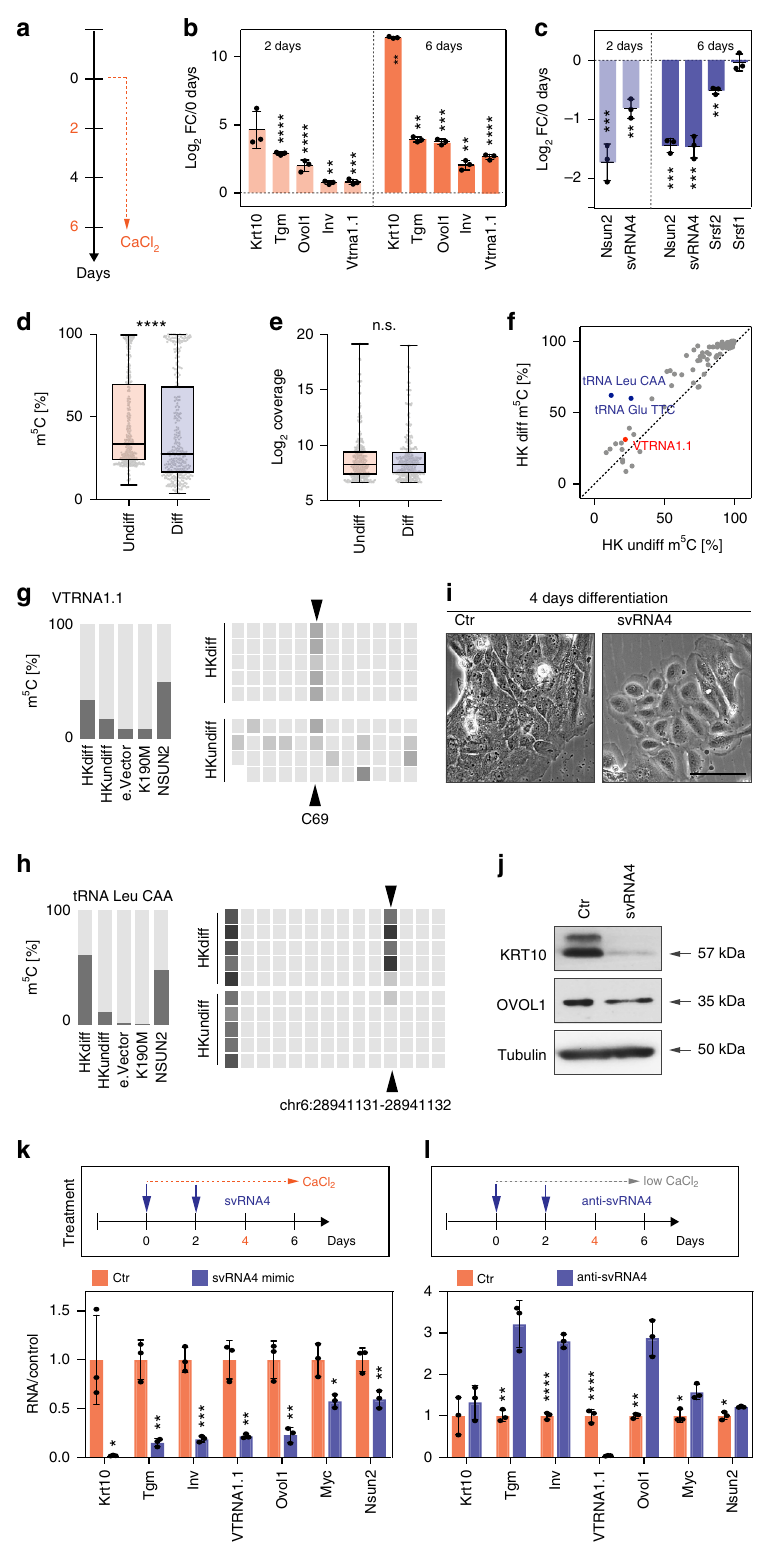
fi broblasts ( n = 76) (Supplementary Data 6). The vast majority of these sites were located in tRNAs and a small number occurred in other non-coding RNAs (Fig. 4f). In contrast to all sites detected in the epidermal cells, most of these NSUN2-methylated RNAs, including VTRNA1.1, showed higher methylation levels in the differentiated condition (Fig. 4f – h). The higher level of